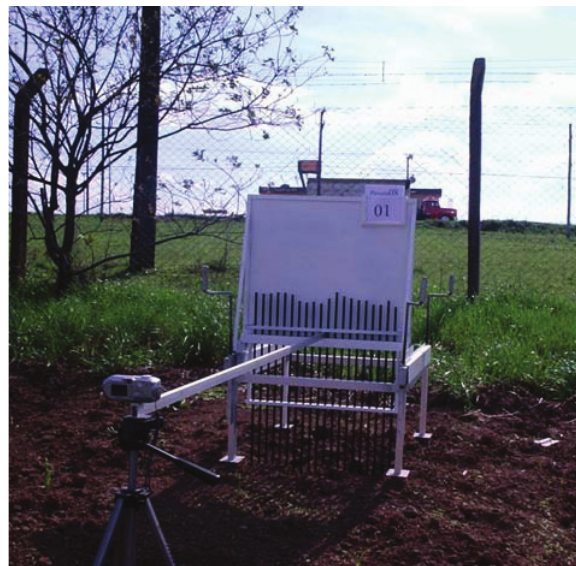
figura 1. Rugosímetro de varetas utilizado no estudo, sendo operado no experimento sobre um cambissolo Húmico alumínico léptico.